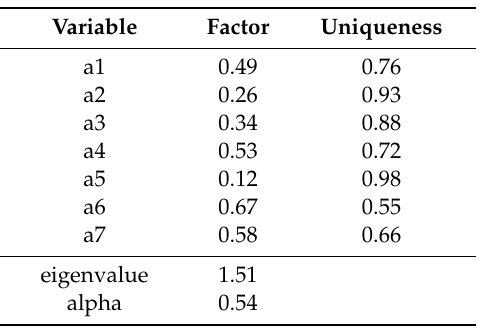
Table A2. Factor loadings using all privacy